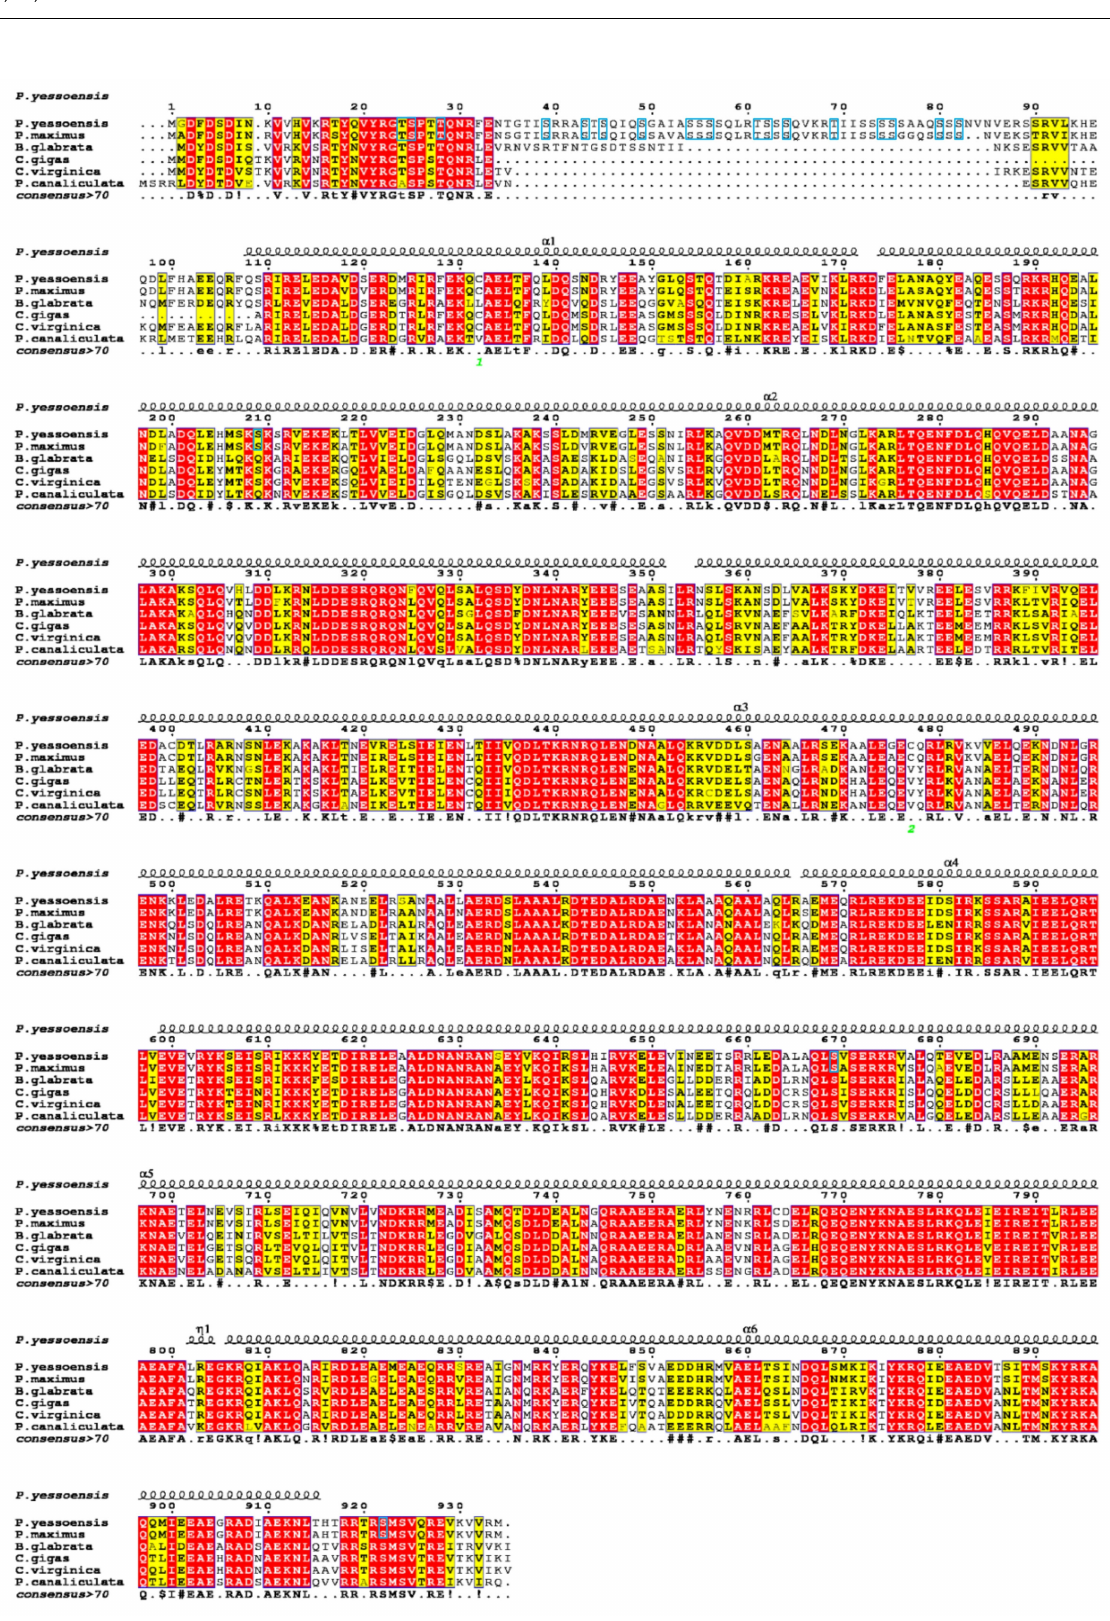
Figure 4. Sequence alignment for amino acid sequences of paramyosin among different molluscan species. The predicted secondary structure of paramyosin is shown at the top. α : α -helix; η : coil. The same phosphorylation sites in P. yessoensis and P. maximus are marked with blue